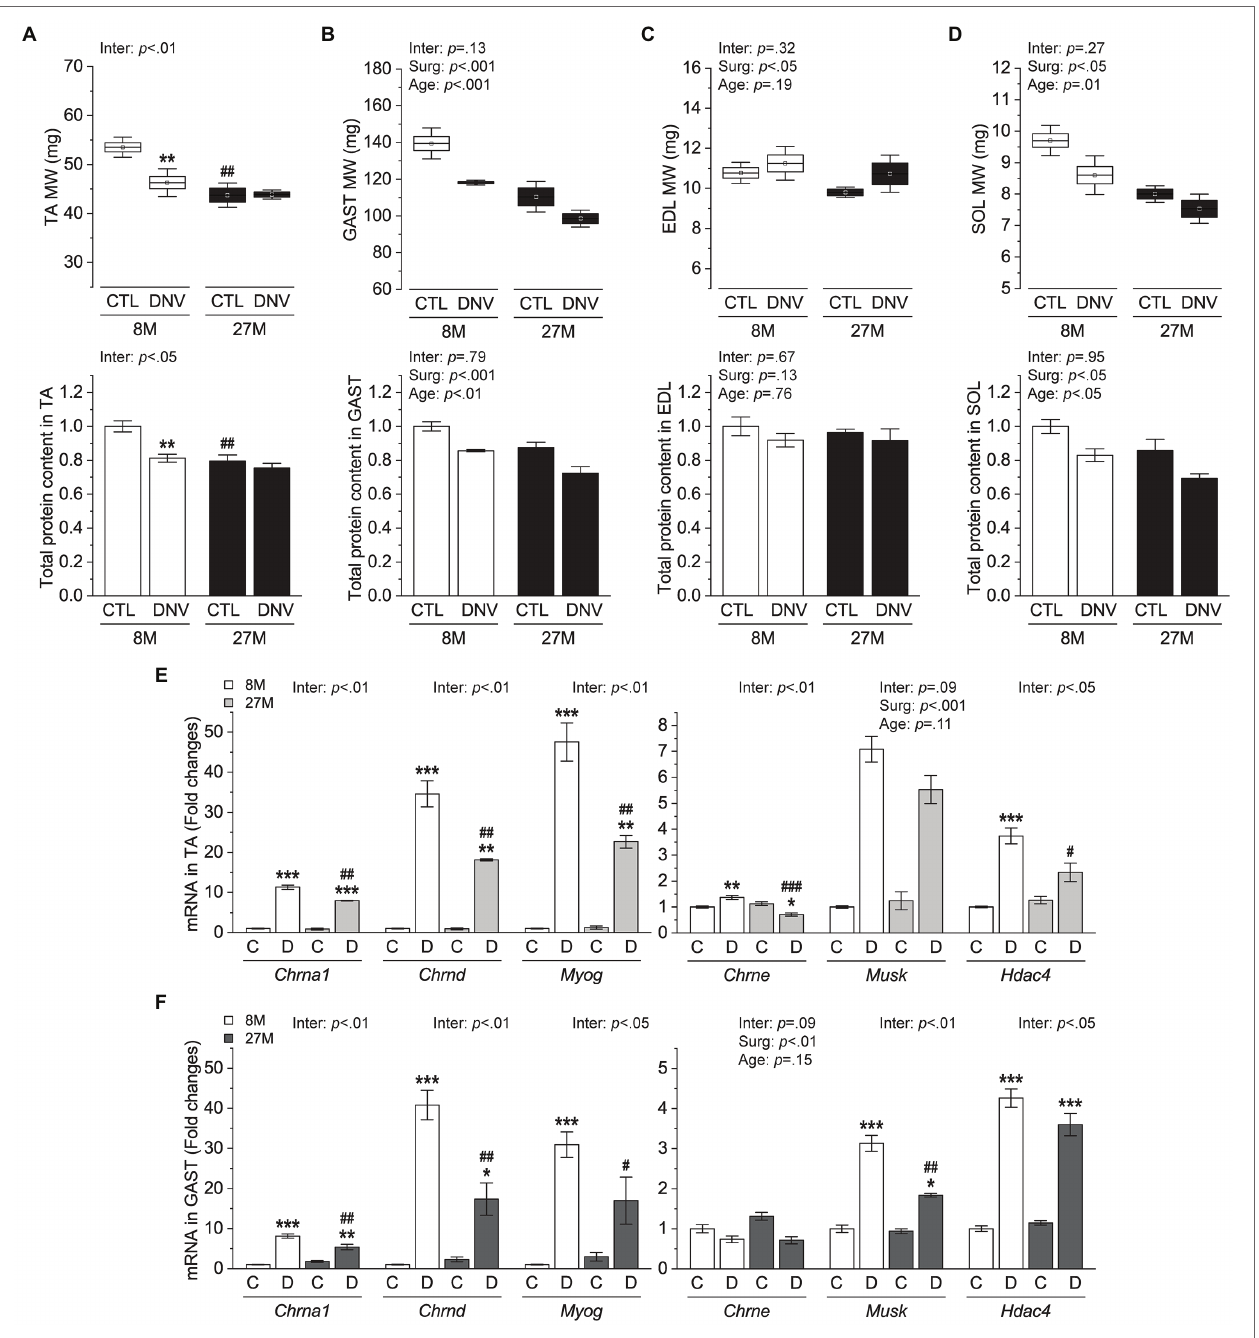
FIGURE 1 | Effects of aging on denervation-induced muscle atrophy. Mice at 8 months (8 M) and 27 months (27 M) of age were subjected to denervation (right leg, DNV or D) and sham (contralateral left leg, CTL or C) surgeries, and tibialis anterior (TA), gastrocnemius (GAST), extensor digitorum longus (EDL), and soleus (SOL) muscles were collected 7 days after surgeries. (A–D) Muscle weight and total protein content in TA (A) , GAST (B) , EDL (C) , and SOL (D) . (E,F) mRNA levels of denervation markers in TA (E) and GAST (F) . n = 5–3 mice/group. Data are presented as mean ± SEM. and SD (whisker, upper panels in A–D ) and expressed relative to 8 M/CTL except for upper panels in (A–D) . * p < 0.05, ** p < 0.01, and *** p < 0.001 vs. CTL by two-way mixed ANOVA. # p < 0.05, ## p < 0.01, and ### p < 0.001 vs. 8 M within the same surgery groups by two-way mixed ANOVA. Inter, interaction between surgery effects (Surg) and age effects by two-way mixed